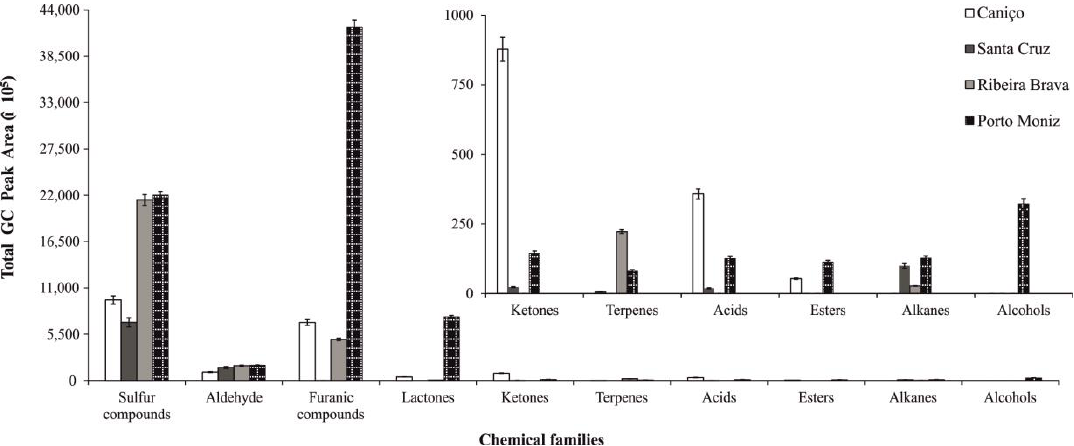
Figure 2. Volatile organic metabolites (VOMs) distribution by chemical groups identified in onions from Spanish cultivated at different geographic regions. Error bars represent mean standard deviation ( n = 3).